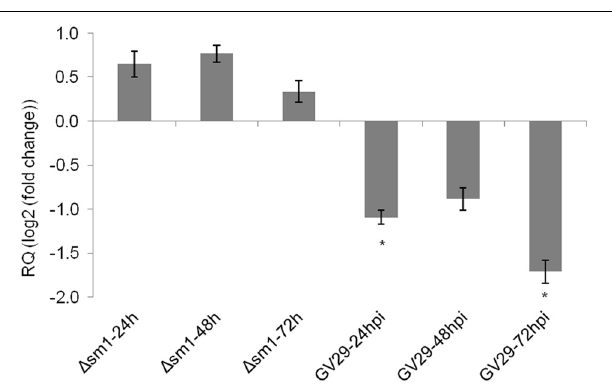
FIGURE 5 | Relative expression of ZmLOX3 in response to root colonization by T. virens strain GV-29-8 and (cid:2) sm1, a mutant that is unable to induce ISR in maize. Two days old disease free seedlings were transferred to hydroponic media with half-strength Murashige and Skooge mediaandwereinoculatedwiththehyphaeofthefungus.Ateachtimepoint, threebiologicalreplicates,eachconsistingofthreeplantsweresampled.The experiment was repeated twice and results were pooled and analyzed together.Thedataareshownasmeanlog 2 (foldchange) ± SEandonlythose means those sample with statistically significant change in gene expression ( α = 5%) are designated with an